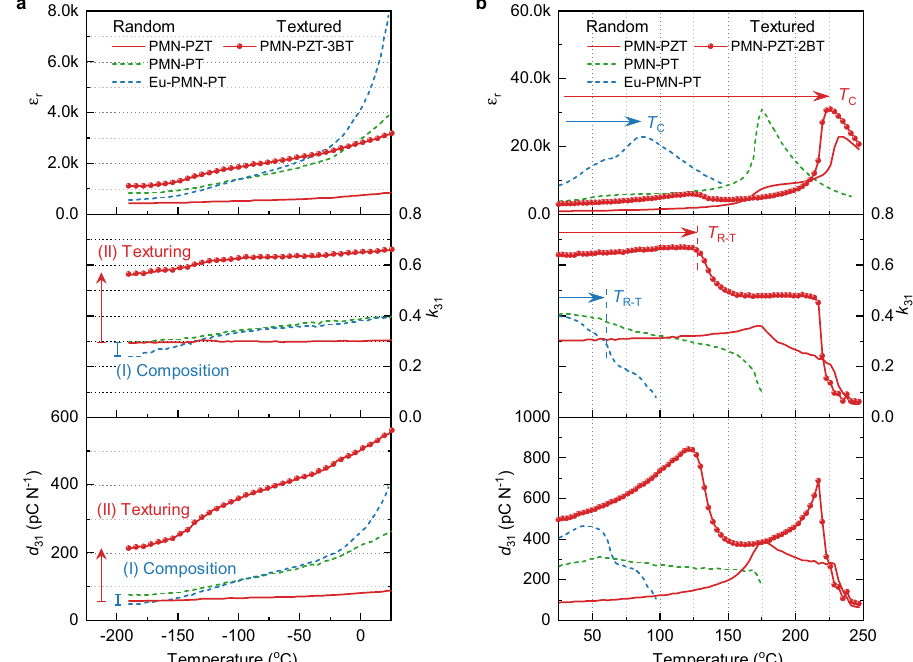
Fig. 5 Temperature dependence of the dielectric, piezoelectric, and electromechanical properties of textured PMN-PZT ceramics. a Properties measured in a low-temperature range from − 190 °C to room temperature, b Properties measured in a high-temperature range from room temperature to 250 °C. The texturing approach provides much larger increments of d and k as well as a wider temperature range (as indicated by higher rhombohedral to tetragonal ferroelectric-ferroelectric phase transition T R-T and ferroelectric-paraelectric phase transition T C ) than the traditional composition approach, as indicated by the vertical and horizontal